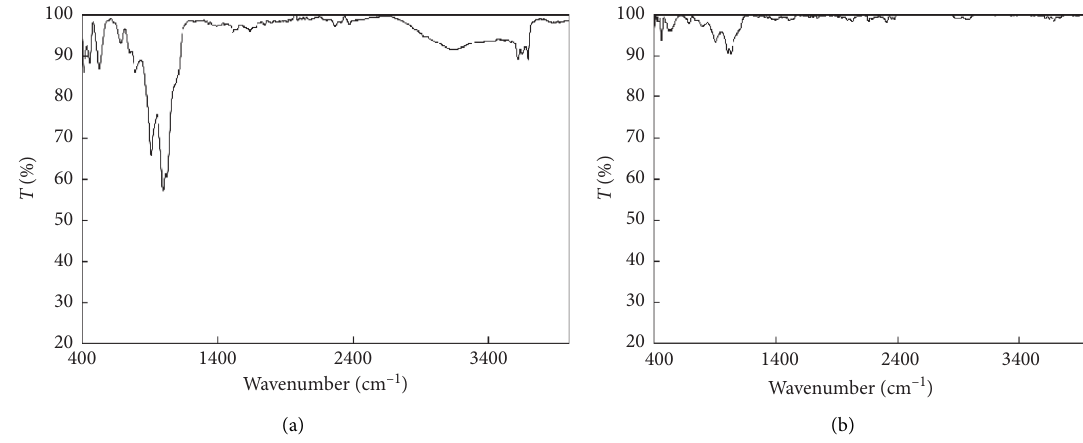
Figure 8: The FT-IR spectra of NCPML before (a) and after (b) TC adsorption in the wavenumber from 400cm − 1 to 4000cm − 1 .